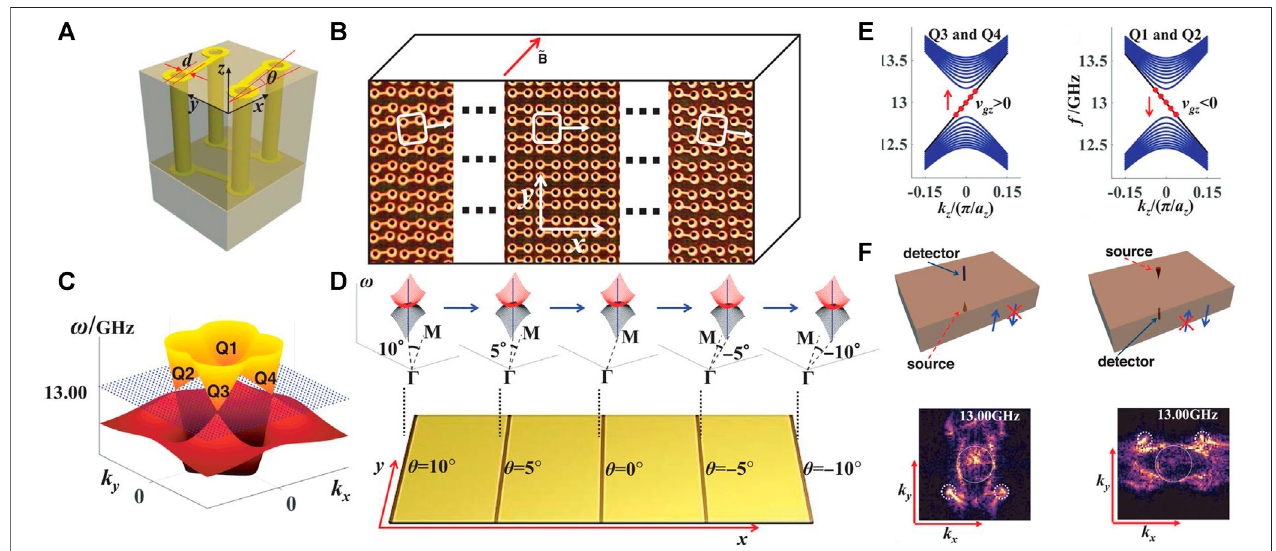
FIGURE7|(A) Saddle-shapedmetalliccoilwithrotationabout z axis[41]. (B) Topsurfaceofthesample.Gradientofrotationalanglealongthe x directiongenerates a synthetic magnetic fi eld alongthe z direction. (C) Dispersion ofthe Weyl metamaterialwithno rotationangle. (D) The position oftheWeyl point Q1 shifts asthe rotation anglevaries linearly with x . (E) Band structures showing Landau levels for Weyl points. (F) Experimental result for up-going(down-going) chiral zero modes around Weyl points Q3 and Q4 (Q1 and Q2).